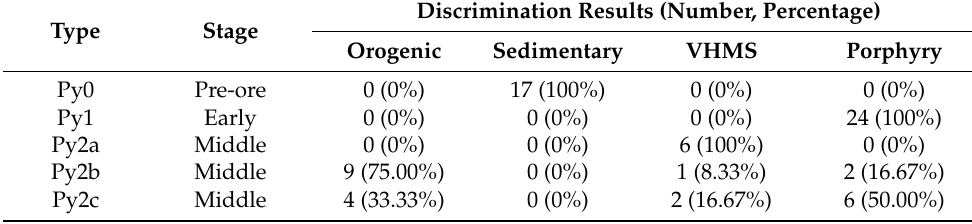
Table 3. Classification results for different types of pyrite from the Dunbasitao gold deposit based on the study by Gregory et al. [22]. Discrimination Results (Number, Percentage) Type Stage Orogenic Sedimentary VHMS Porphyry